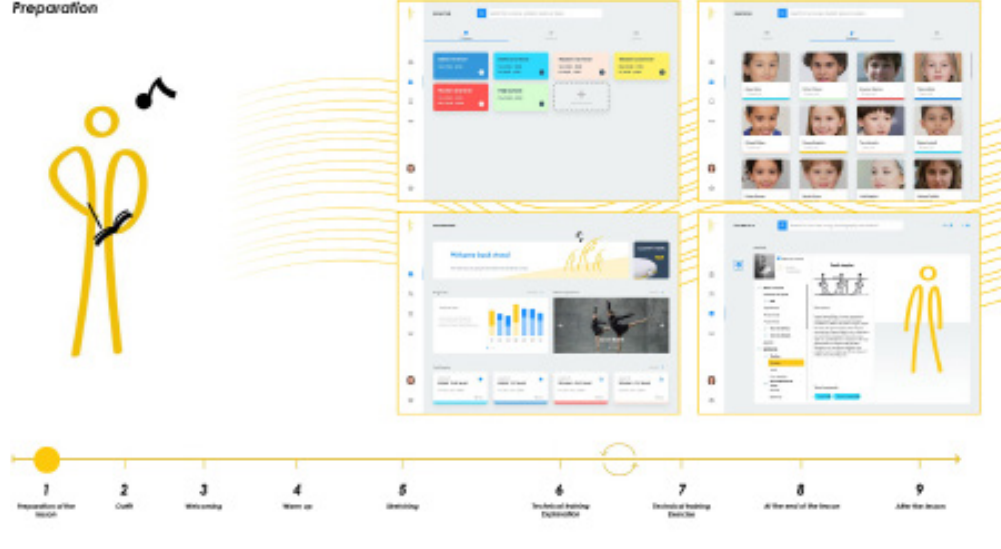
Fig. 14 Zambonini A., mock-up of the graphic interface of the